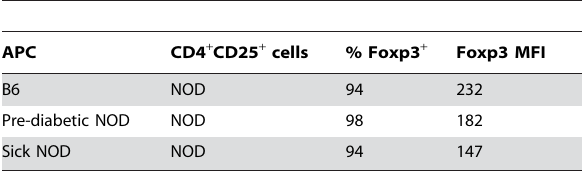
Table 1. In vitro assay to evaluate APC-mediated maintenance of Foxp3 expression by CD4 + CD25 + T cells.